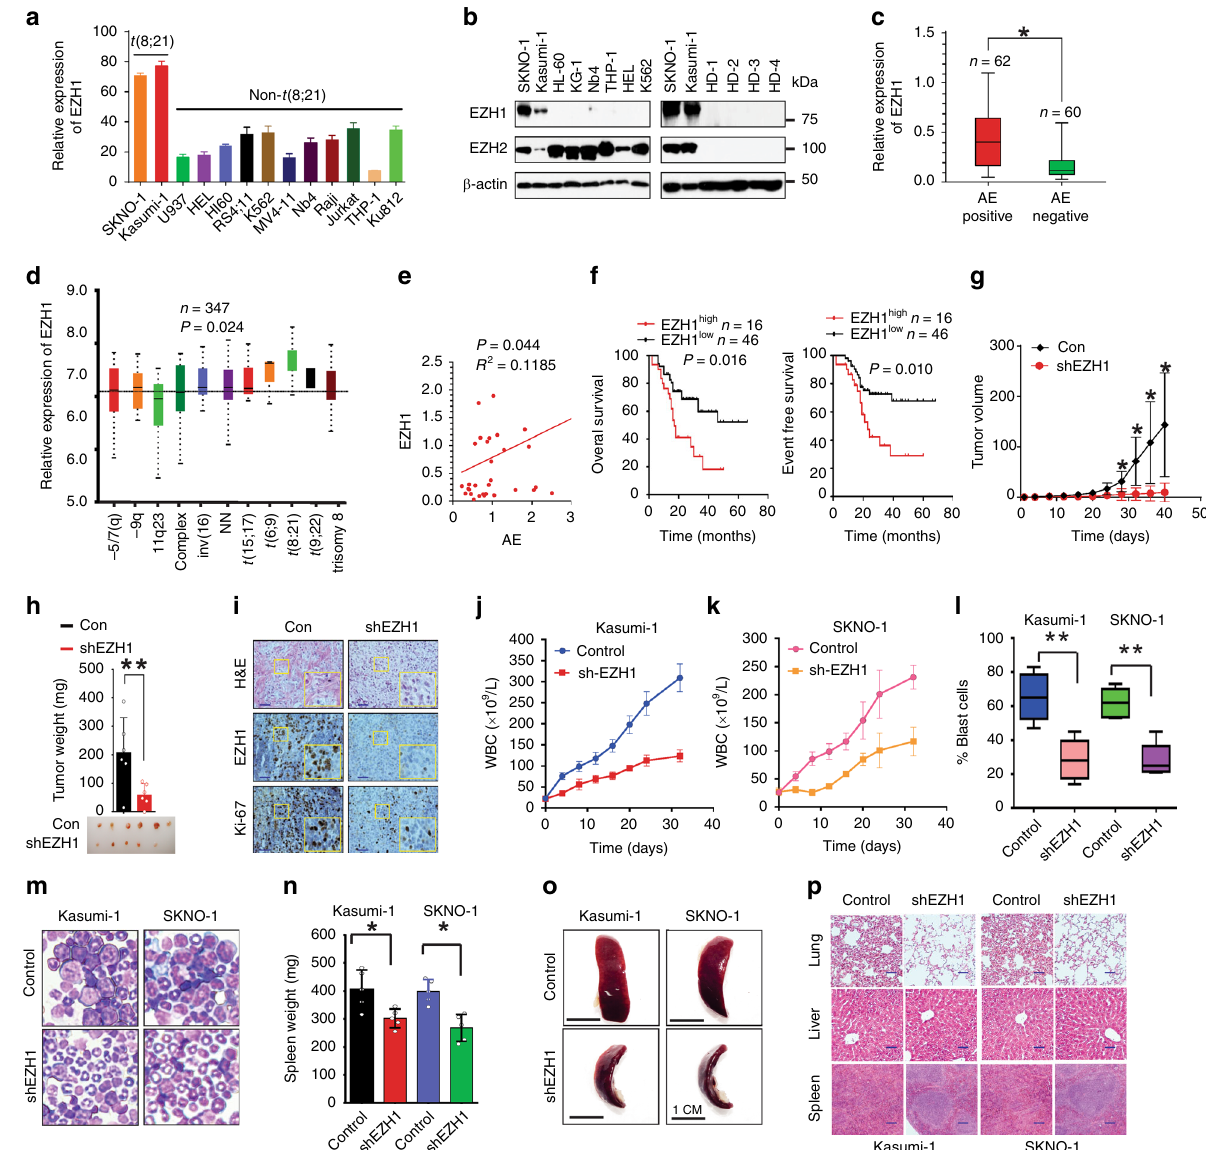
Fig. 1 EZH1 promotes AML1-ETO leukemia. a qPCR for EZH1 mRNA expression in leukemia cell lines ( n = 3). b Western blotting for EZH1 and EZH2 protein expression in leukemia cells lines and healthy human donors (HD). c qPCR for EZH1 mRNA expression in AML1-ETO-positive ( n = 62) and negative ( n = 60) leukemia patients. Median values are depicted by the horizontal lines. * P < 0.05. d Normalized EZH1 expression in primary cells of de novo AML patients (GSE6891) ( n = 347). NN refers to normal karyotype. Patient characteristics are summarized in Supplementary Table 2. e Correlation analysis for AML1-ETO and EZH1 mRNA expression in AML1-ETO-positive leukemia patients ( n = 62). R: Pearson correlation coef fi cients; R 2 : indicates “ the goodness of fi t ” . Statistical signi fi cance was calculated by Pearson correlation coef fi cients. f The association of EZH1 expression with overall survival (OS) and event free survival (EFS) in AML1-ETO-positive patients ( n = 62; from Fig. 1c) analyzed by the Kaplan – Meier estimate ( n = 62). g , h EZH1-depleted and control SKNO-1 cells were injected subcutaneously into the fl anks of nude mice. The measurement of xenograft tumor size ( g ), and the visual analysis and